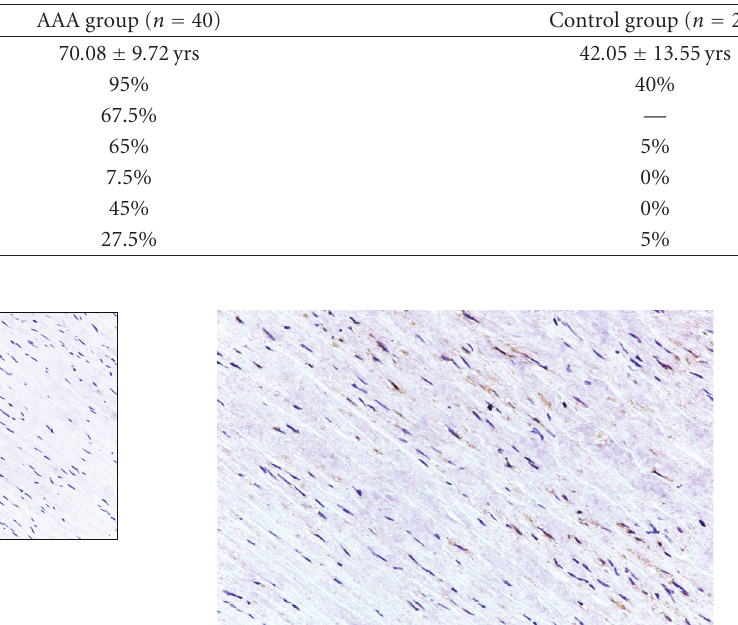
Table 1: Patient characteristics of AAA patients group and control group.